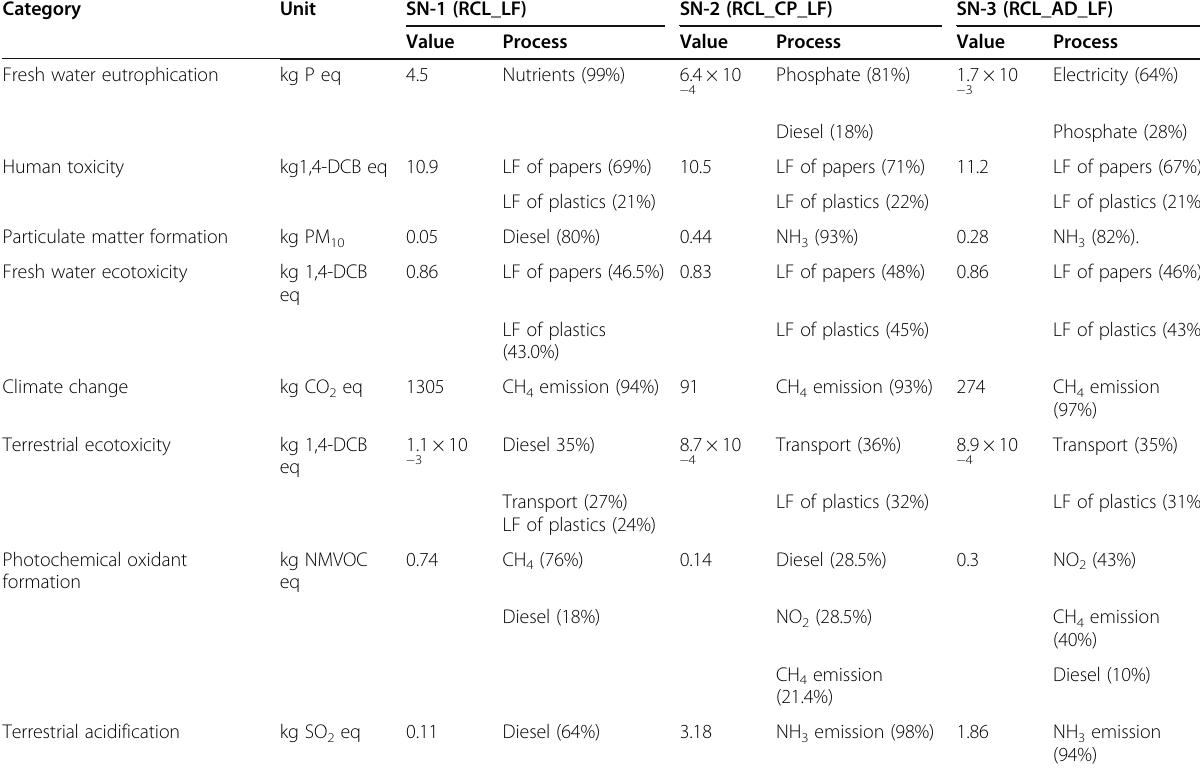
Table 4 Environmental impacts of systems without resources recovery